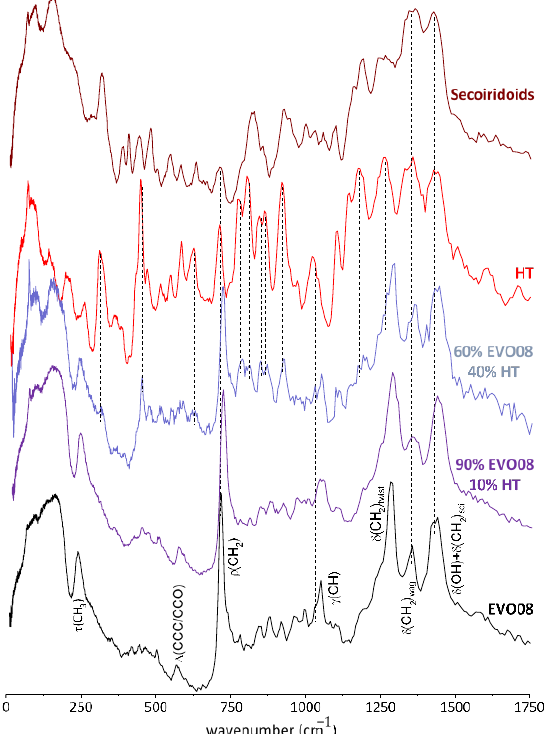
Figure 2. INS spectra (0–1750 cm − 1 ) of extra virgin olive oil (EVOO8), hydroxytyrosol (HT) and secoiridoids, and two different mixtures of EVOO8 and HT (9:1 and 6:4)).